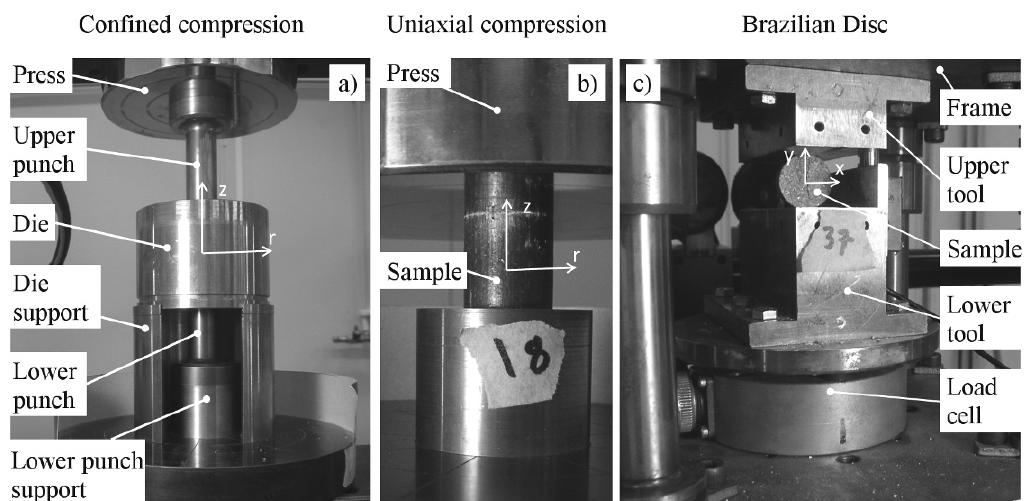
Figure 4. Test setups for the soil material characterization. In a) the confined compression is shown and in b) the uniaxial compression is shown; c) shows the Brazilian disc test.